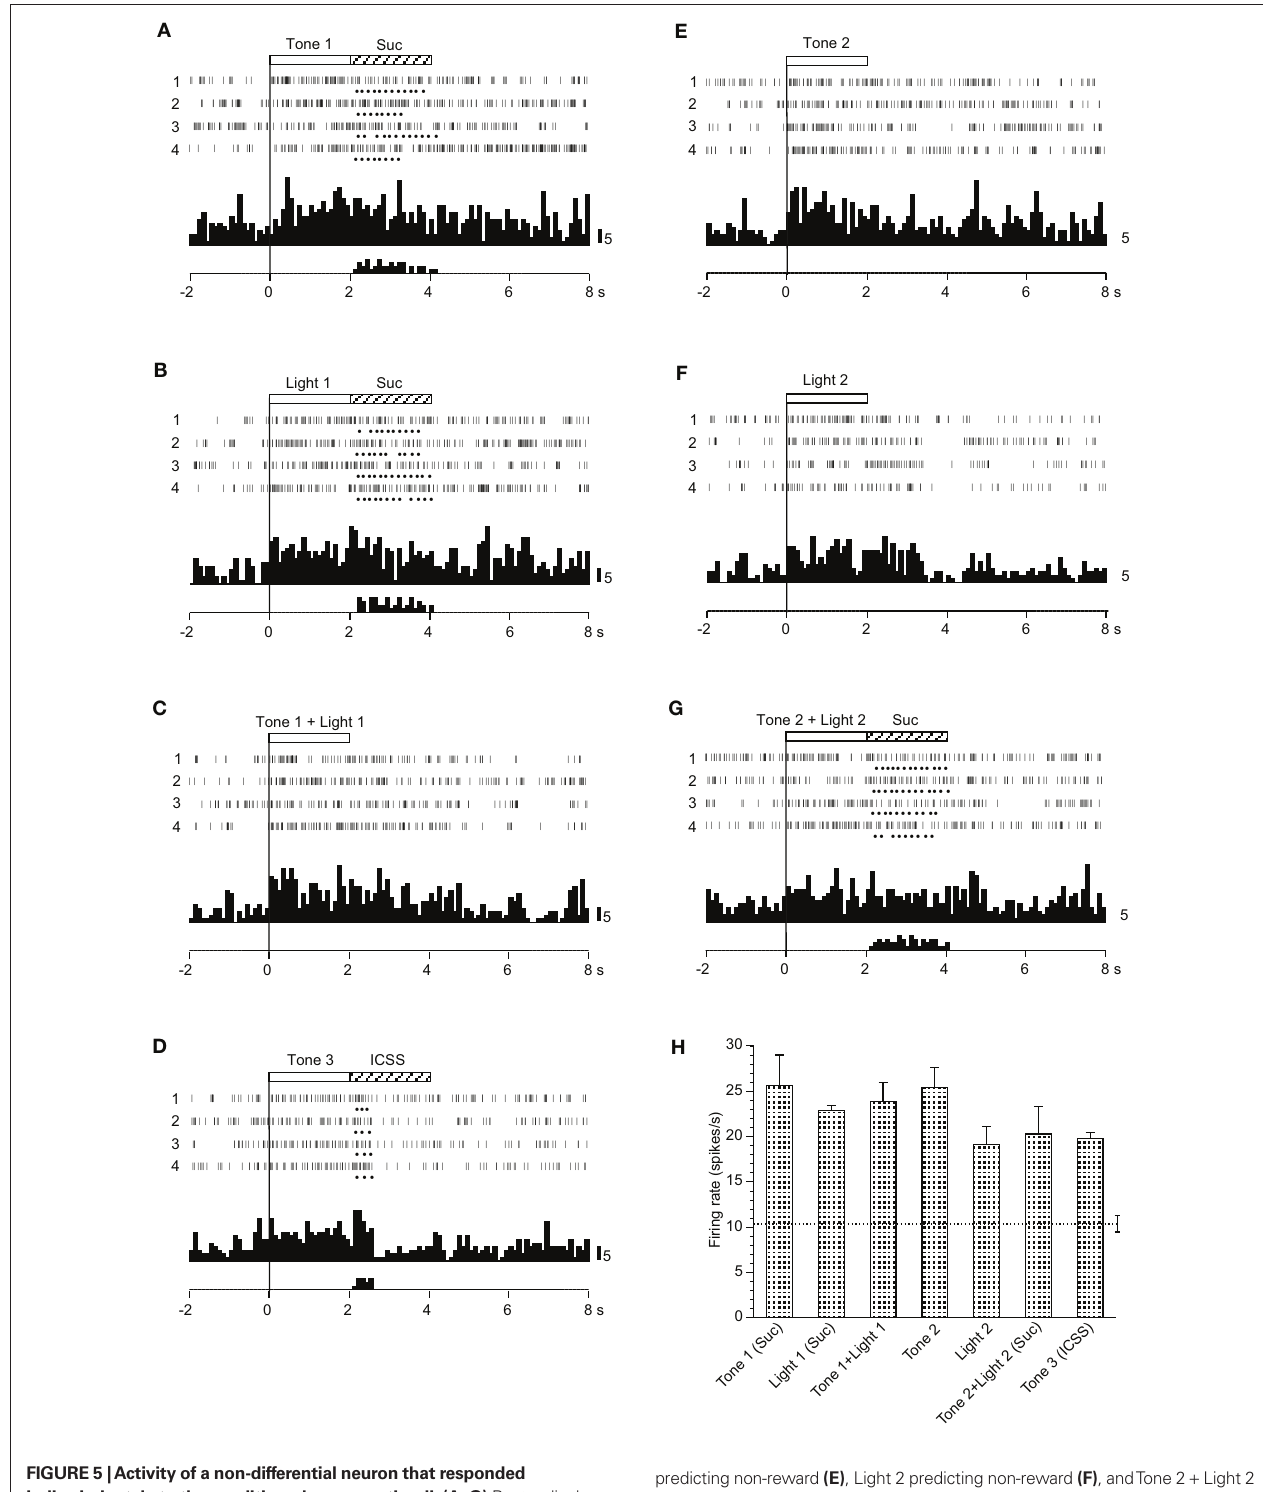
predicting non-reward (e) , Light 2 predicting non-reward (F) , and Tone 2 + Light 2 predicting the sucrose solution (g) . Note that neuronal activity increased during presentation of all CSs. (H) Histogram of neuronal responses during presentation of each CS (mean firing rate ± SEM). Other descriptions as in Figure